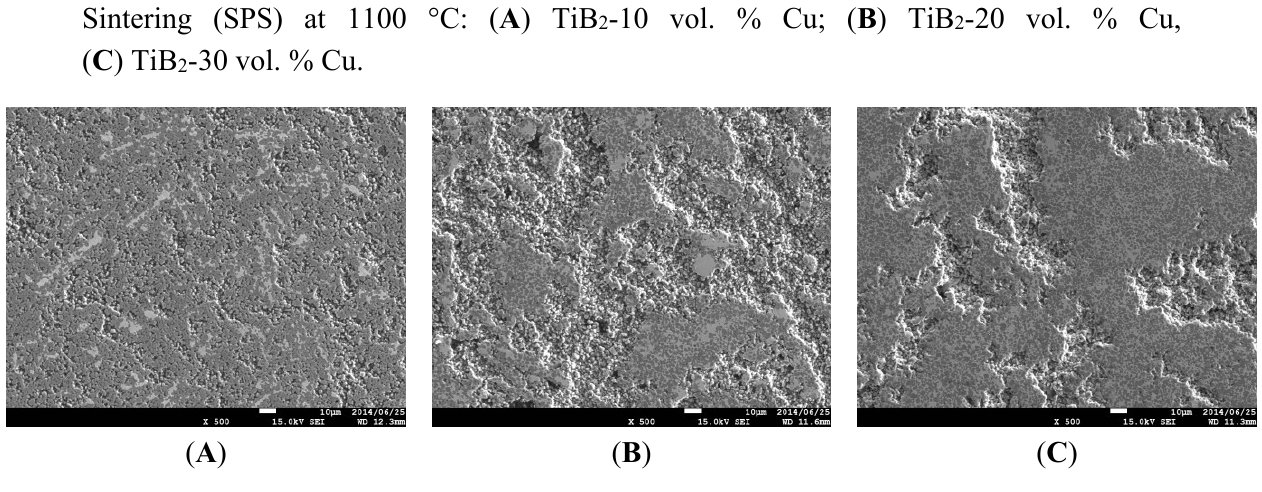
Figure 4. SEI of the TiB 2 -Cu cermets with various copper content after Spark